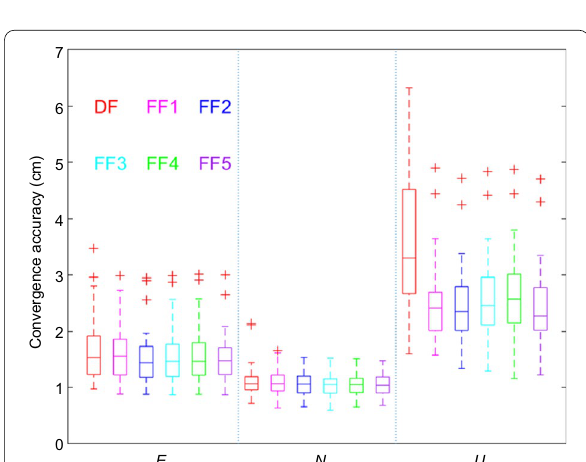
Fig. 6 Boxpolt of the three-dimensional RMS with different models for the selected 20